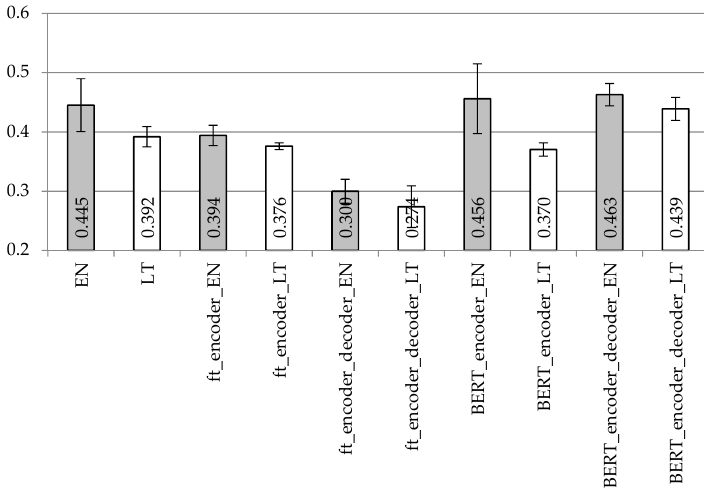
Figure 10. Averaged BLUE scores with confidence intervals using the BiLSTM encoder and LSTM decoder model with different vectorization types on the dataset with separated punctuation.